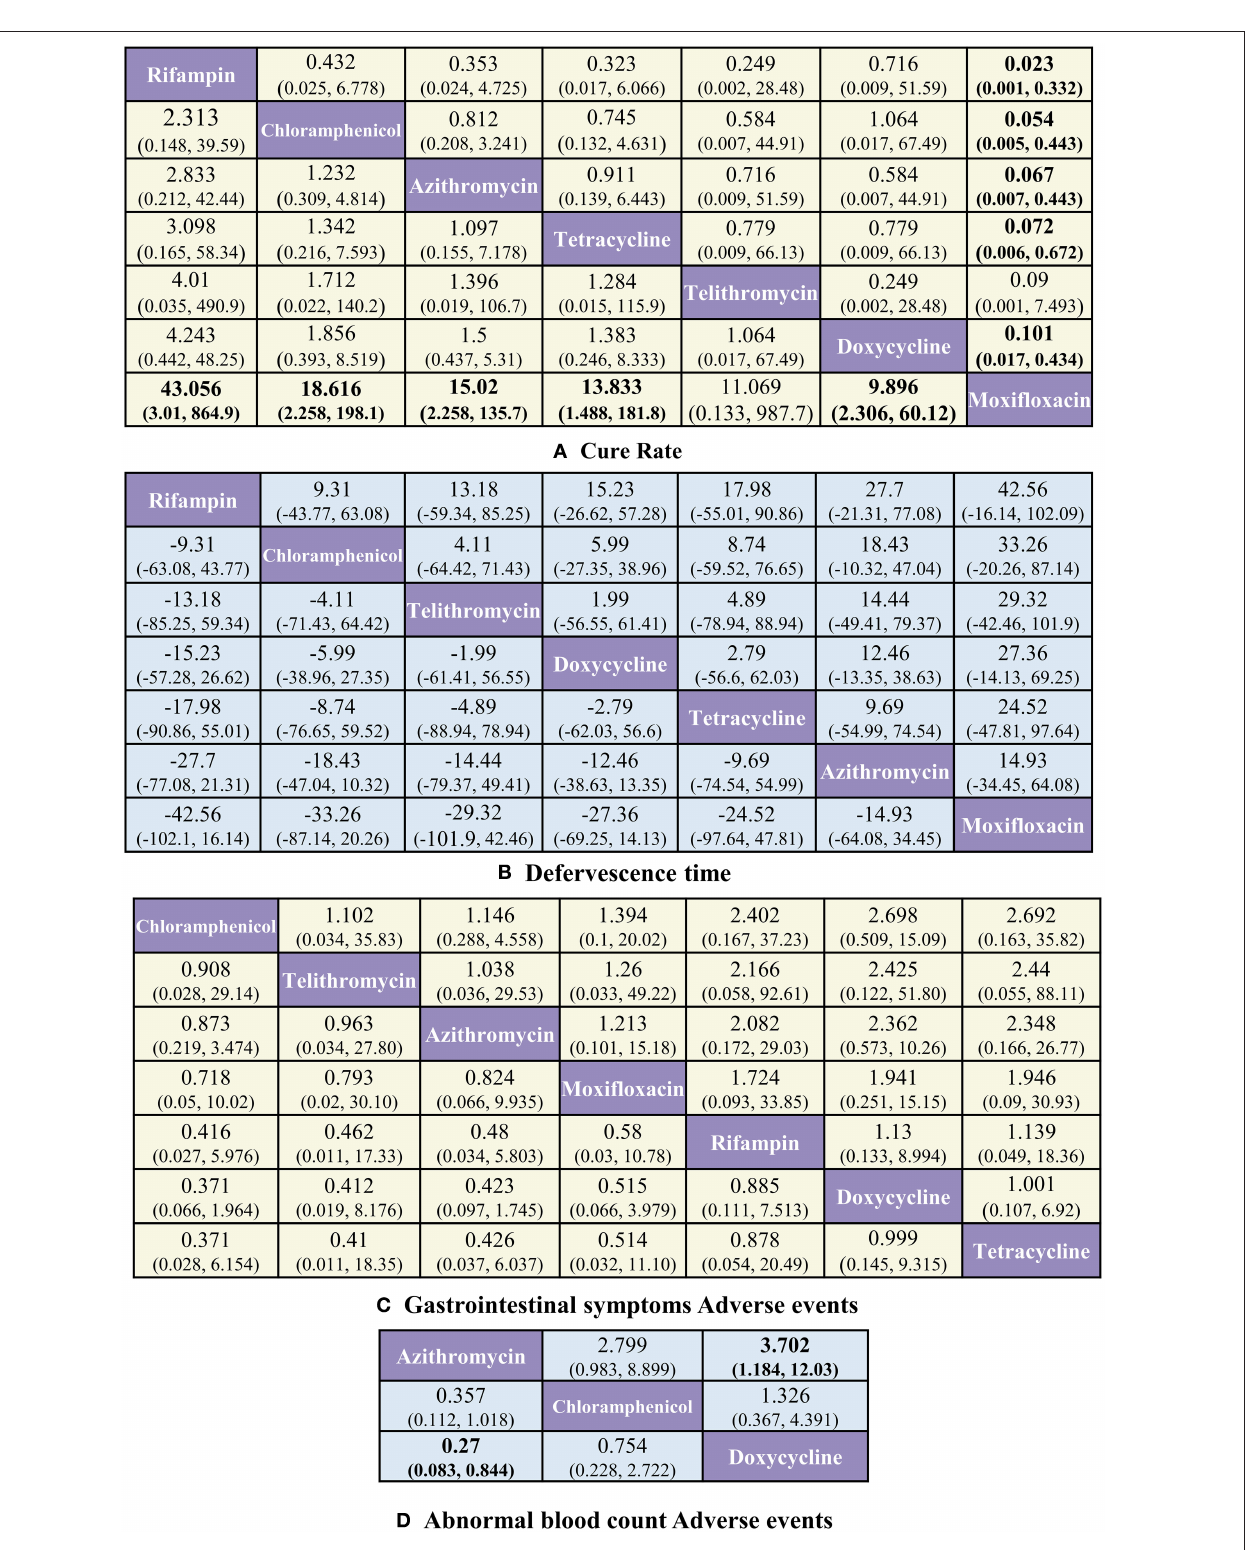
Frontiers in Public Health |